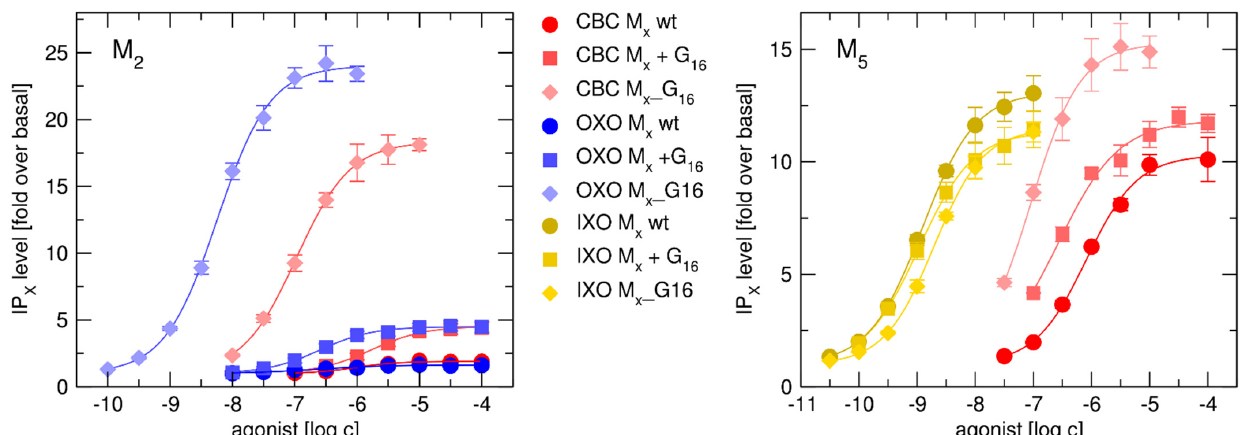
Figure 4. Comparison of functional response of M 2 and M 5 receptor variants to agonists. Accumulation of inositol phosphates (IPx) induced by increasing concentration of agonists carbachol (CBC-red), oxotremorine(OXO-blue), or iperoxo (IXO-yellow) in CHO cells expressing wt (circles), G α 16 subunit co-transfected (diamonds) or G α 16 _fused (squares) M 2 (left graph) and M 5 (right graph) receptors. Data are expressed as folds over the basal level (in absence of agonist) and bottom is equal to 1. Data are means ± SD from three independent experiments performed in triplicate. Table 3. Comparison of parameters of functional response of variants of M 2 and M 5 receptor. Parameters of agonist-in- duced functional response EC 50 and E´ MAX were obtained by fitting Equation (5) to data from measurement of the accumu- lation of inositol phosphates. Operational efficacy τ , agonist equilibrium dissociation constant K A and agonist relative intrinsic activity RA i were calculated according to Equations (5)–(7), respectively. EC 50 and K A are expressed as negative logarithms. Values of system E MAX are (30.7 ± 0.603 for M 2 _G α 16 ; 29 ± 3 for M 5 _G α 16 ; 5.8 ± 0.4 for M 2 + G α 16 ; 21 ± for M 5 +